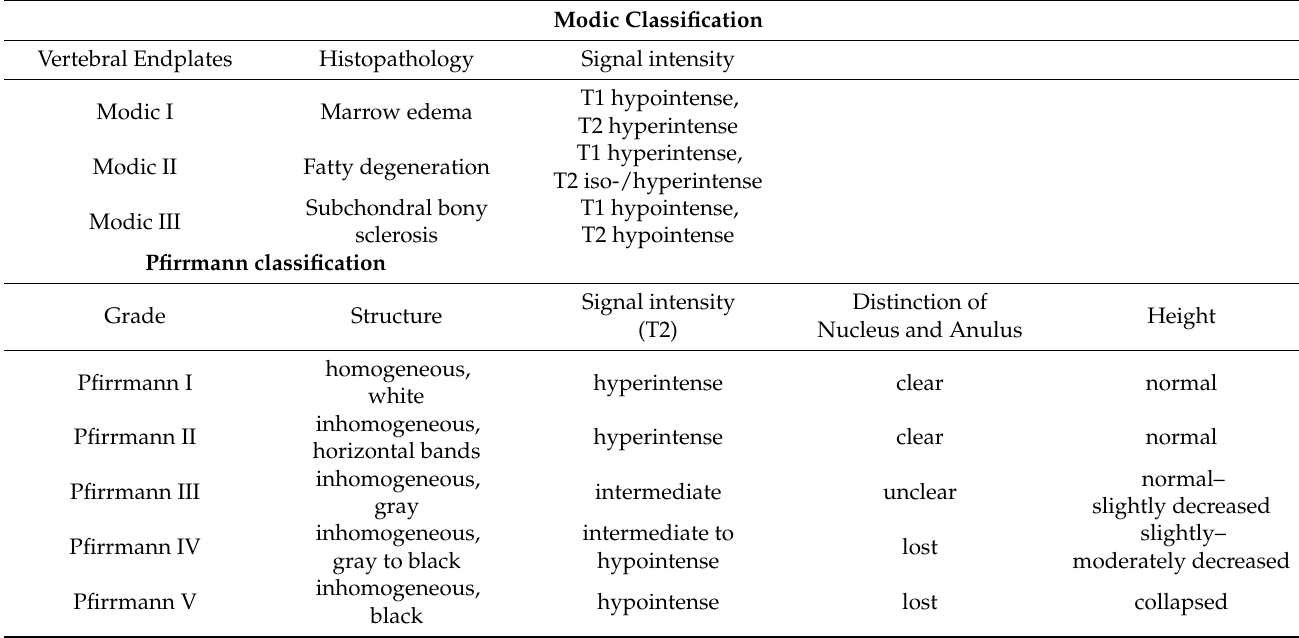
Table 3. Modic classification of endplate changes and Pfirrmann classification of lumbar intervertebral disc degeneration. Modic